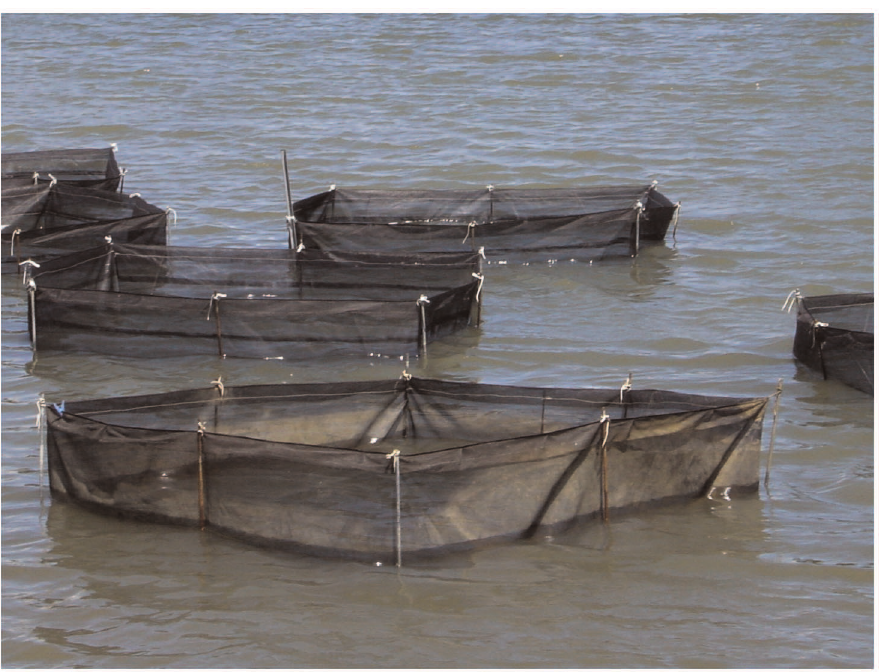
Figure 3. Coarse-mesh enclosures. Photograph of some 2 m 6 2 m 6 1-m-high coarse-mesh enclosures (1-mm mesh) in an earthen pond.